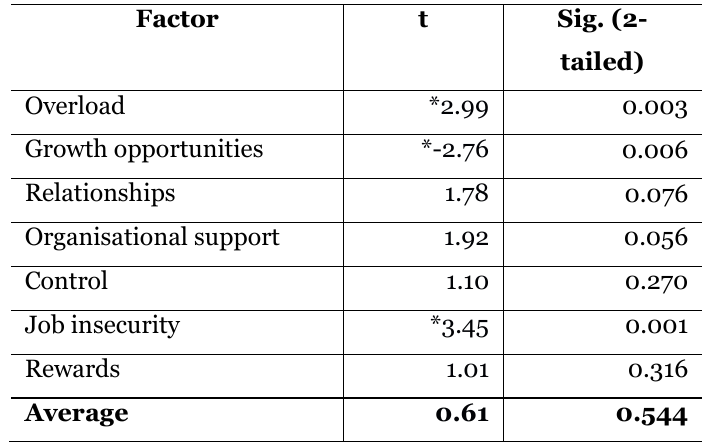
Table 4.2 Independent Samples T-Test by